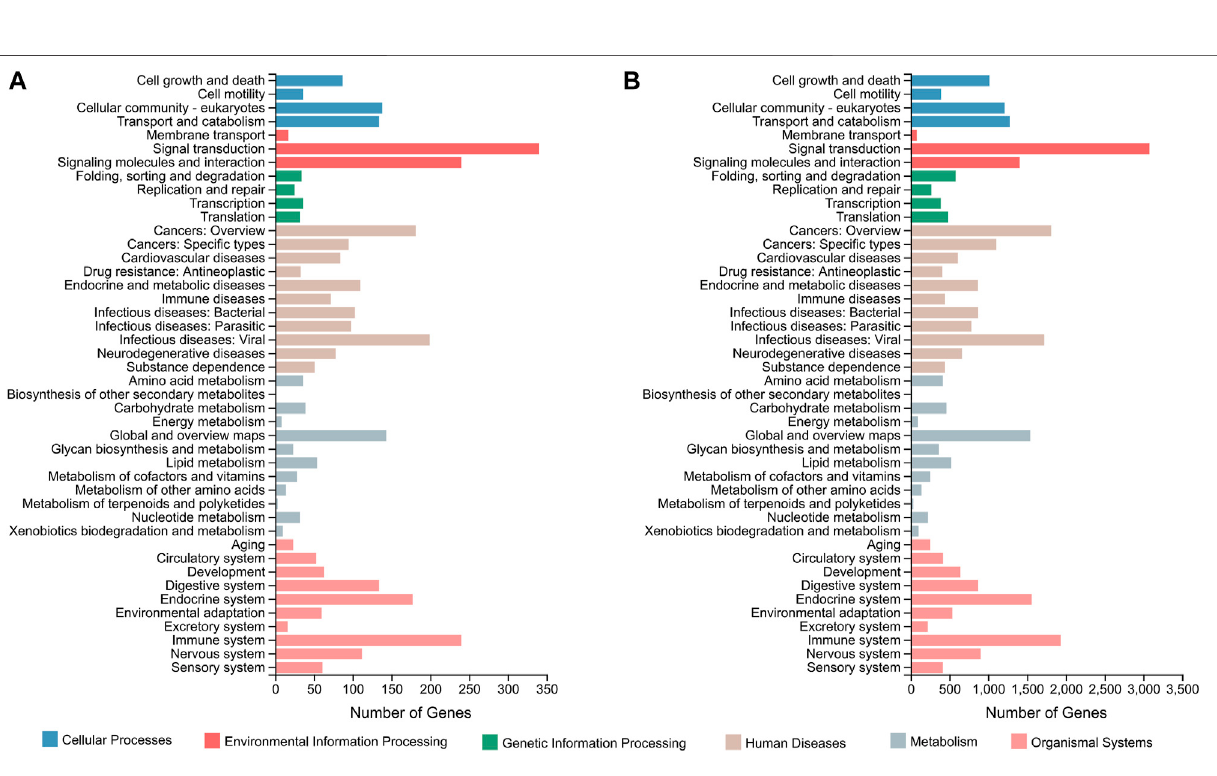
Frontiers in Genetics |